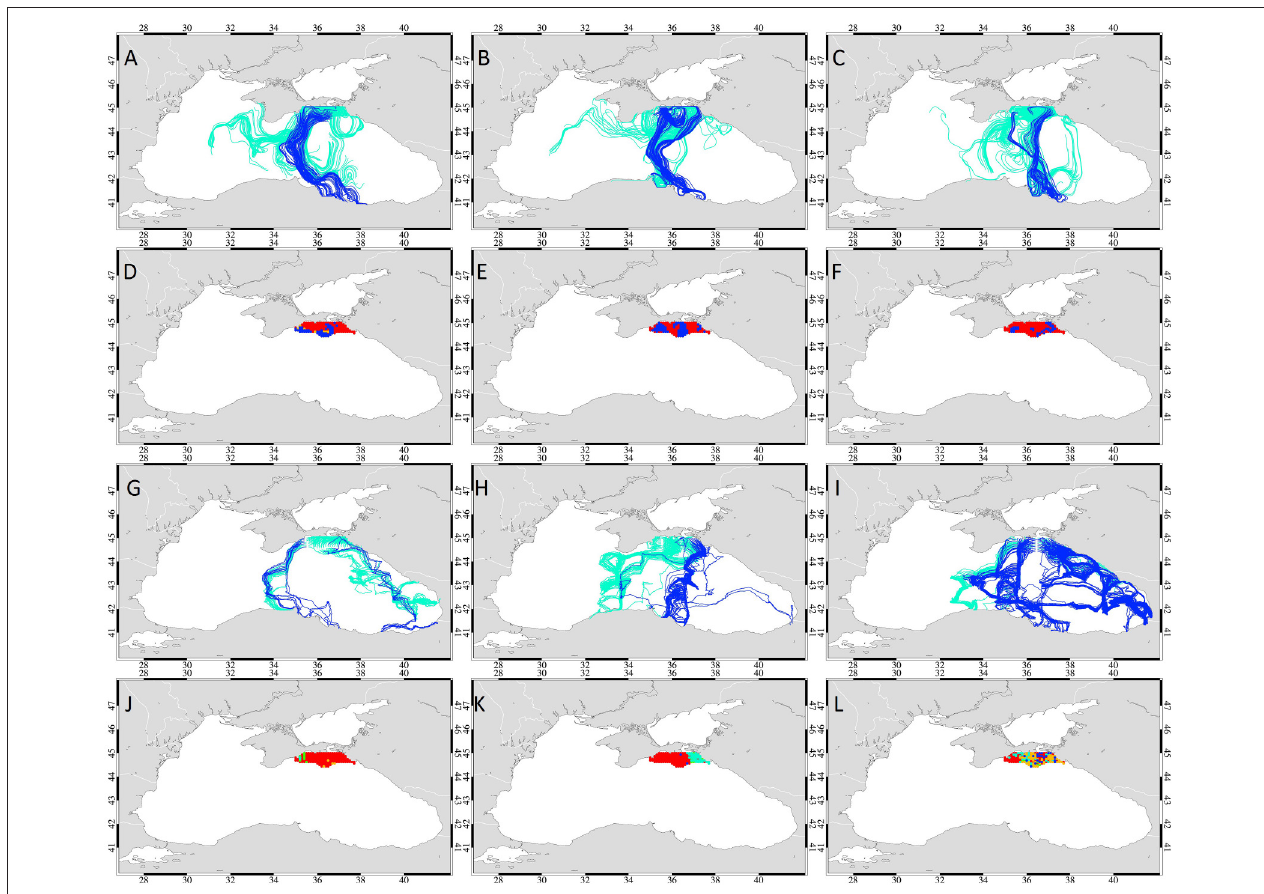
FIGURE 8 | Simulations of interannual variability: The paths (A–C,G–I) and start points (D–F,J–L) of drifters released at Kerch Strait exit area at the end of October. Drifters were advected by surface geostrophic currents alone (A–F) and followed temperature gradients (G–L) swimming 5 bl/s in 2001, 2002, and 2003 (left, middle, and right column). The paths of drifters reaching the overwintering area in 2 months are marked blue, the ones that do not reach are marked green. The start points of drifters that complete a successful migration in 2, 4, 6, and 8 weeks are color-coded green, cyan, yellow and dark blue, respectively. The start points of the drifters that fail to reach the overwintering grounds are marked